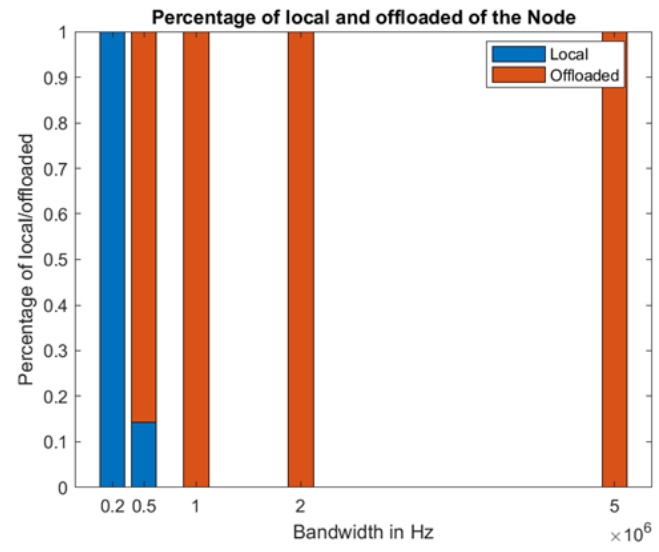
Figure 10. Percentage of locally computed and offloaded